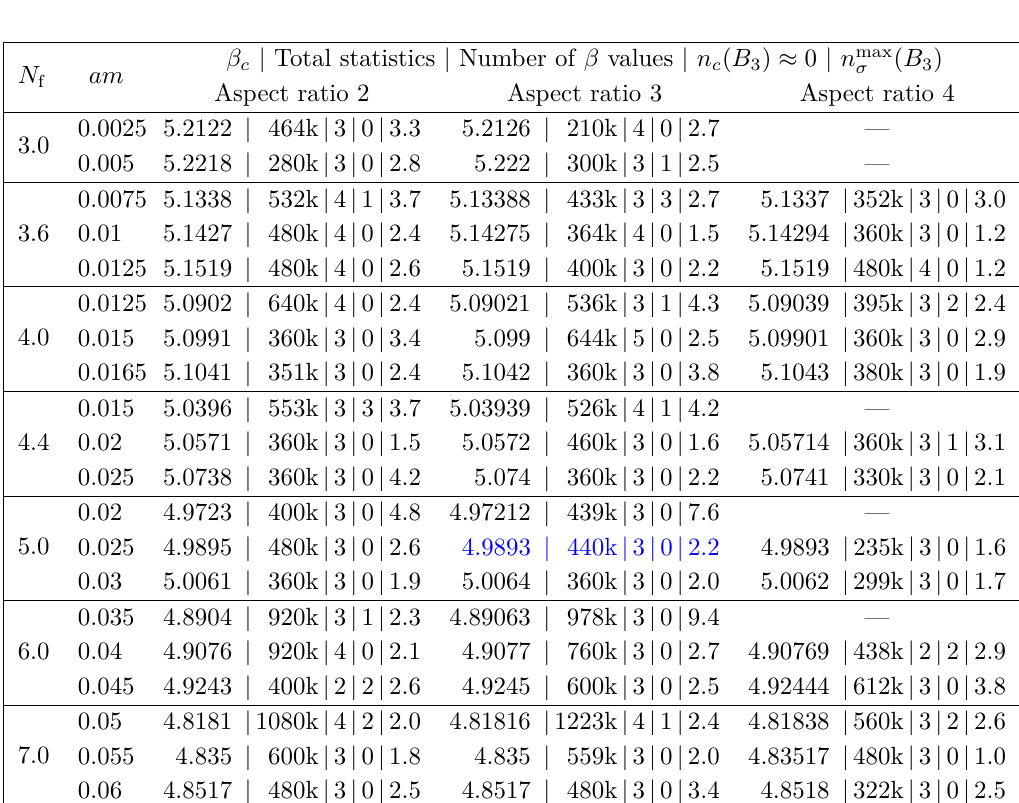
Table 7. Statistics overview for N τ = 6 . The coloured value refers to N σ = 16 , which is slightly smaller than aspect ratio